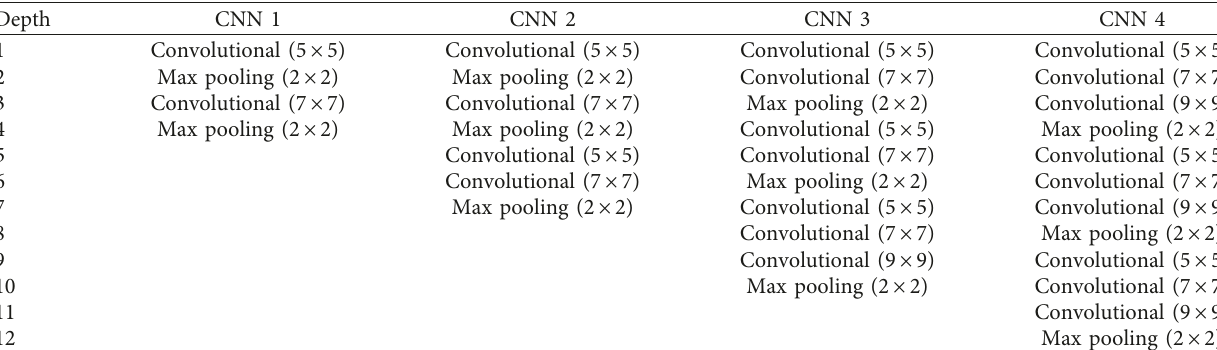
Figure 13: Gestures S (a) and T (b) after AND logical operation with the hand segmented image. Table 1: Proposed CNN